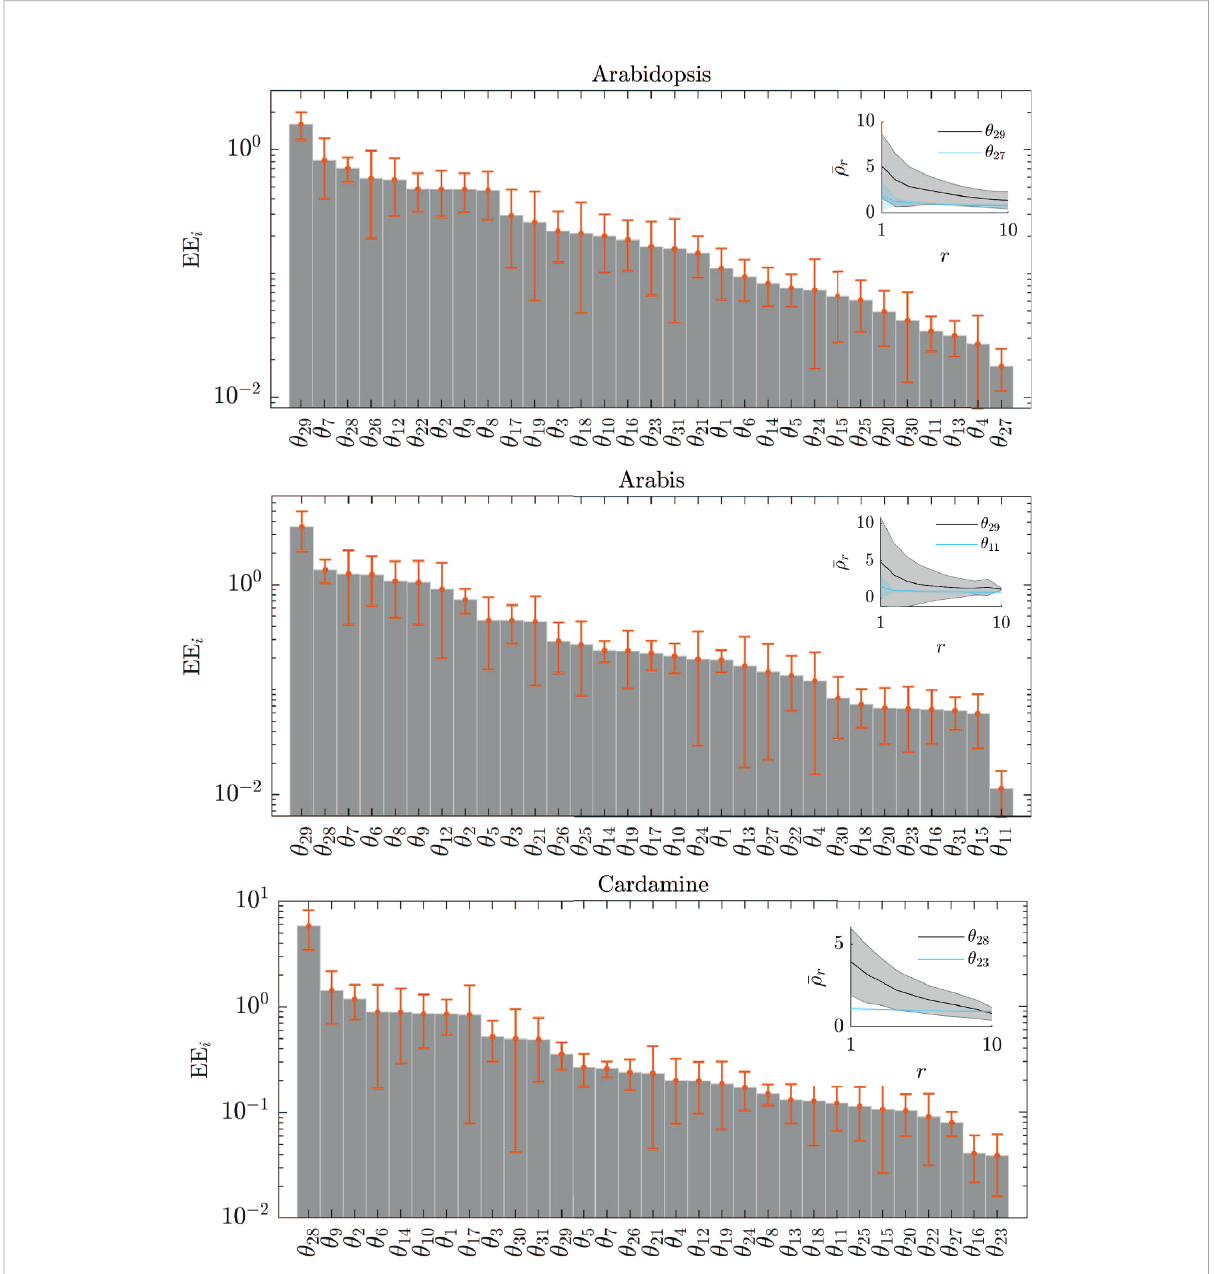
FIGURE 5 Sensitivity of parameters to trichome density. The elementary effects (EEs) of each of the parameters q i in the model indicates the sensitivity of the trichome density to changes in q i , sorted by the respective EE value. The error bars indicate the standard deviation in the EE for the ten best- fi tting parameter sets. The inset shows the average and the spread (shaded region) of the trichome density ( (cid:1) r r ) for the ten best- fi tting parameter sets at each of the ten grid points r of the EE test, for the most sensitive parameter (grey) and the least sensitive parameter